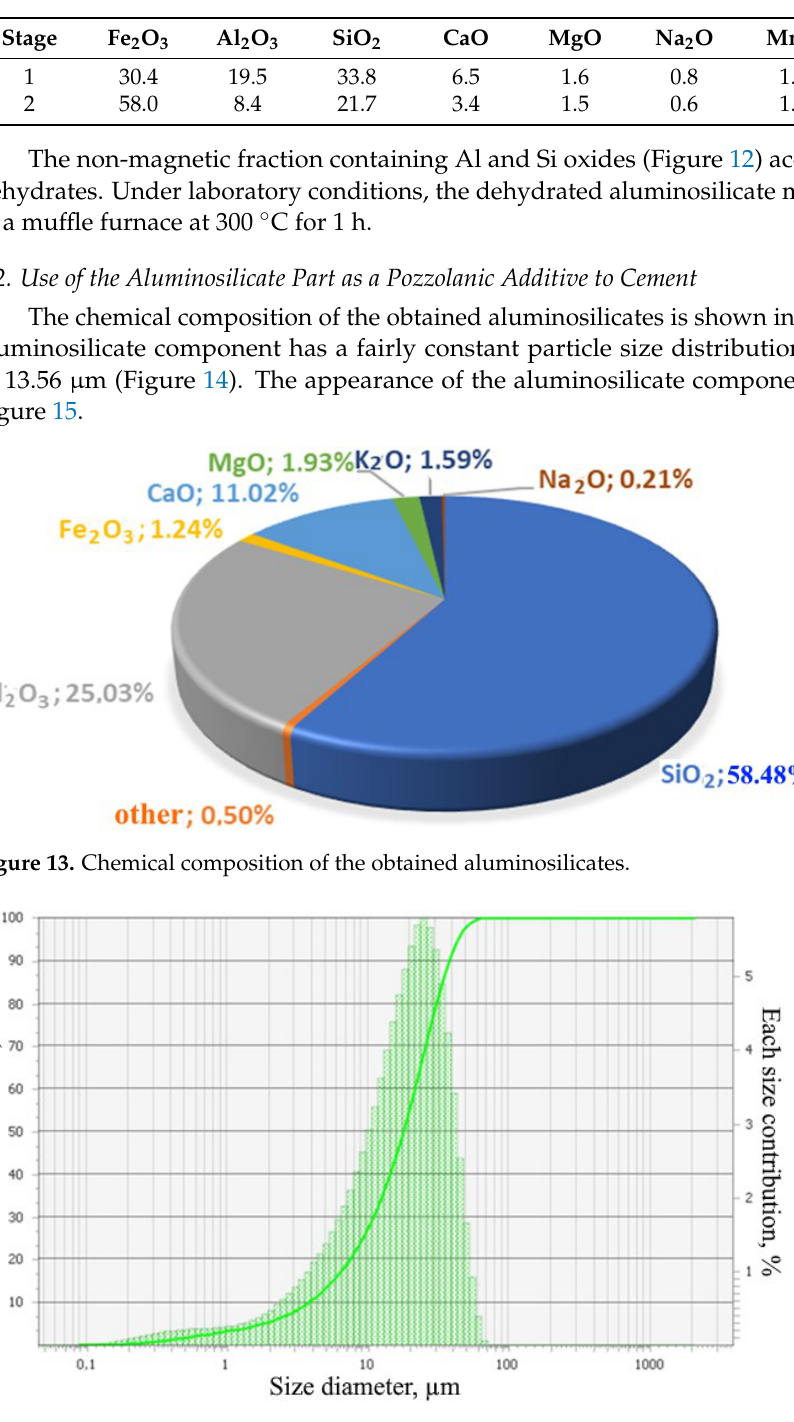
Figure 14. Particle size distributions of the aluminosilicate